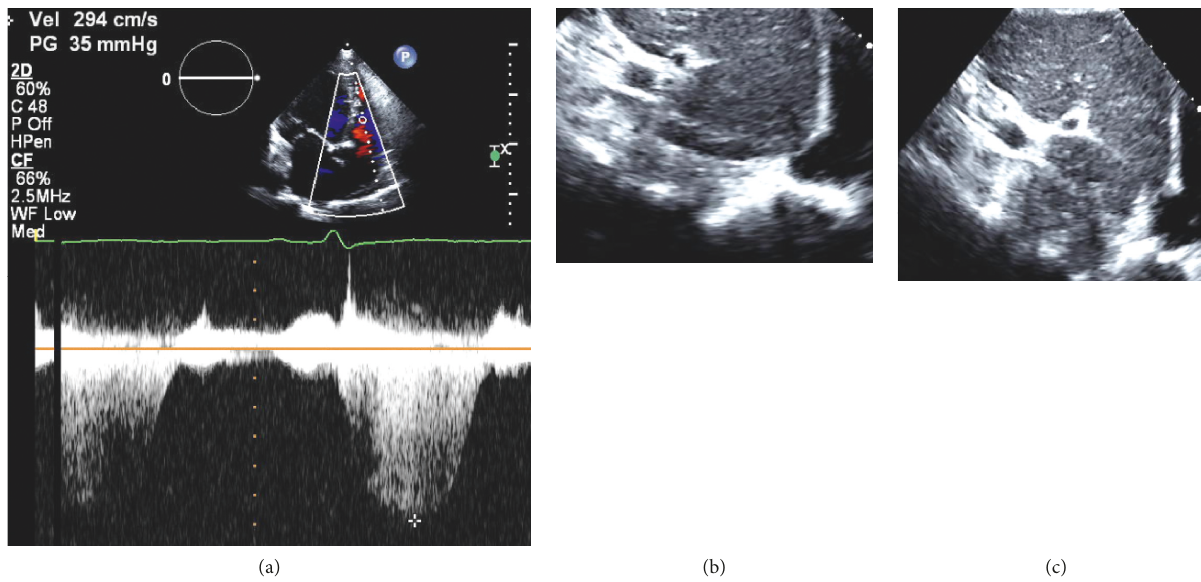
Figure 3: Transthoracic echocardiogram to determine right ventricular systolic pressure (RVSP). (a) Continuous-wave Doppler mea- surement of peak tricuspid regurgitant velocity of 2.9m/s. Right ventricular systolic pressure is calculated via the modified Bernoulli � 4 × ( V ) 2 or Δ P � 4 × ( 2 . 9m/s ) 2 � 34mmHg. A small inferior vena on expiration (b) that completely collapses on equation Δ P TR TV TV inspiration (c) consistent with a mean right atrial pressure of 5mmHg.